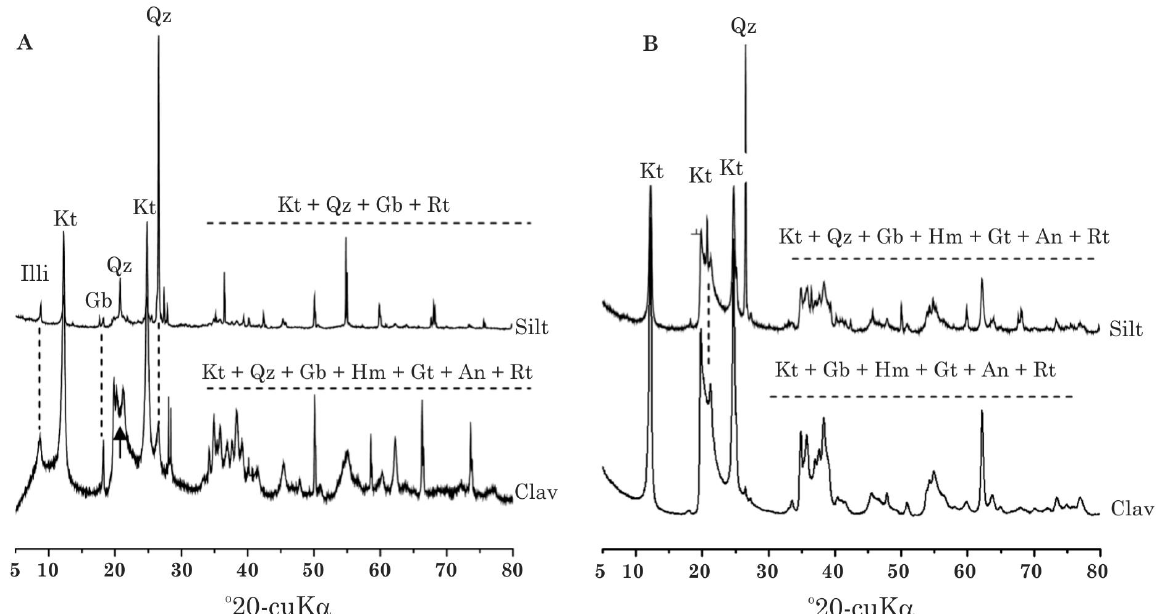
Figure 1. X-ray diffraction patterns of the silt and clay fractions of the Inceptisol (A) and Oxisol (B). Illi = Illite; Kt = Kaolinite; Gb = Gibbsite; Qz = Quartz; Hm = Hematite; Gt = Goethite; An = Anatase; Rt =